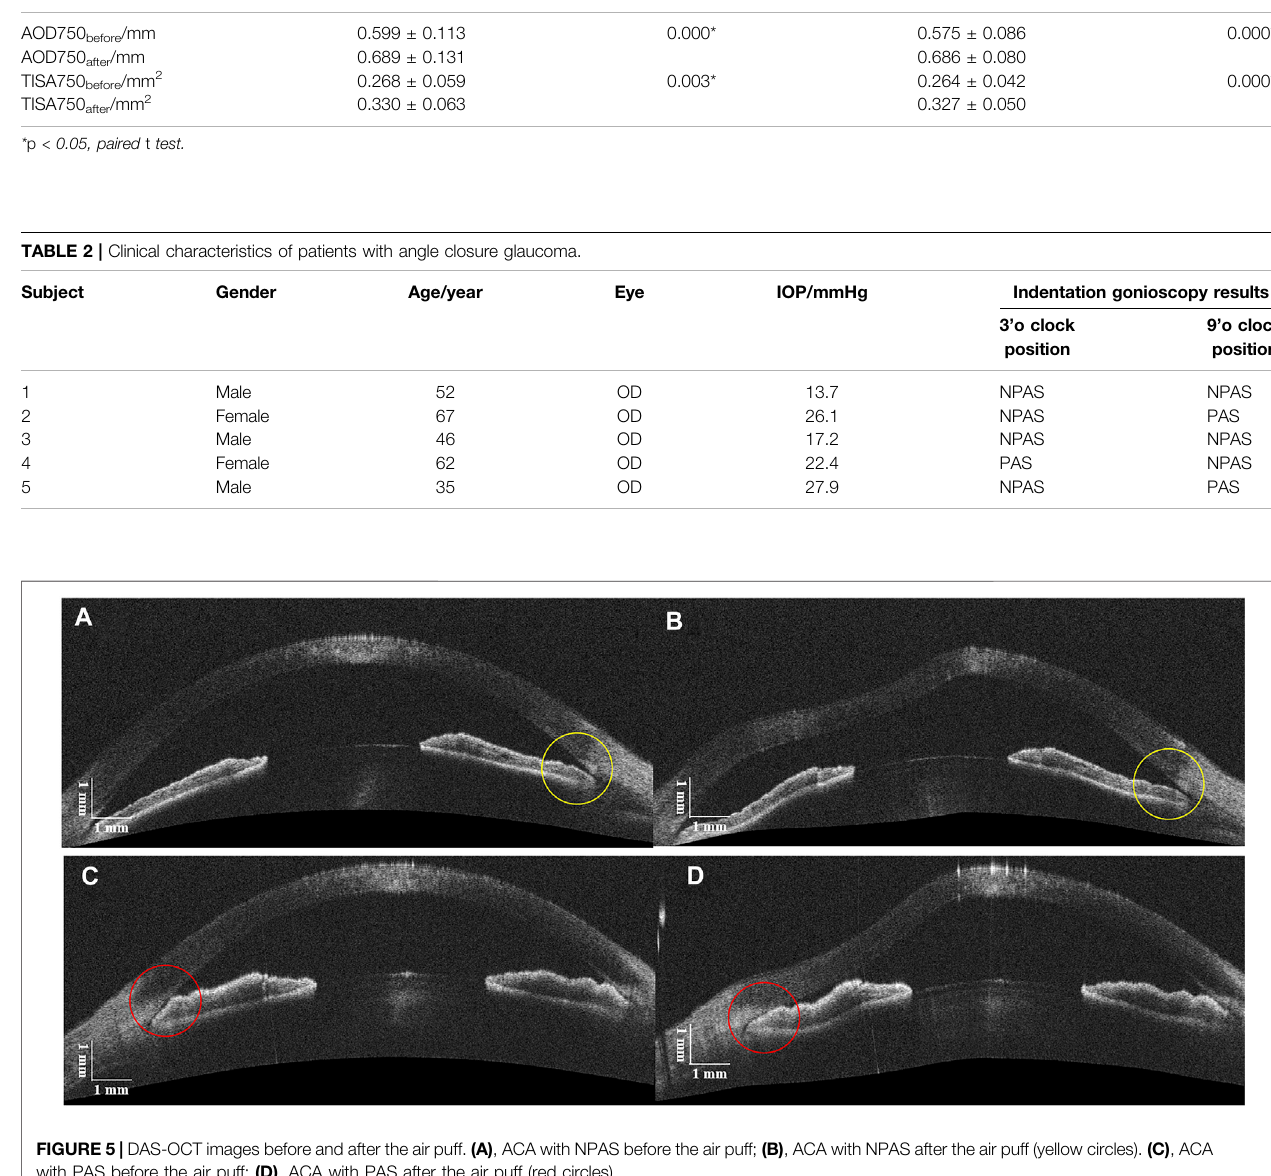
The same side ( n = 10) mean ± SD